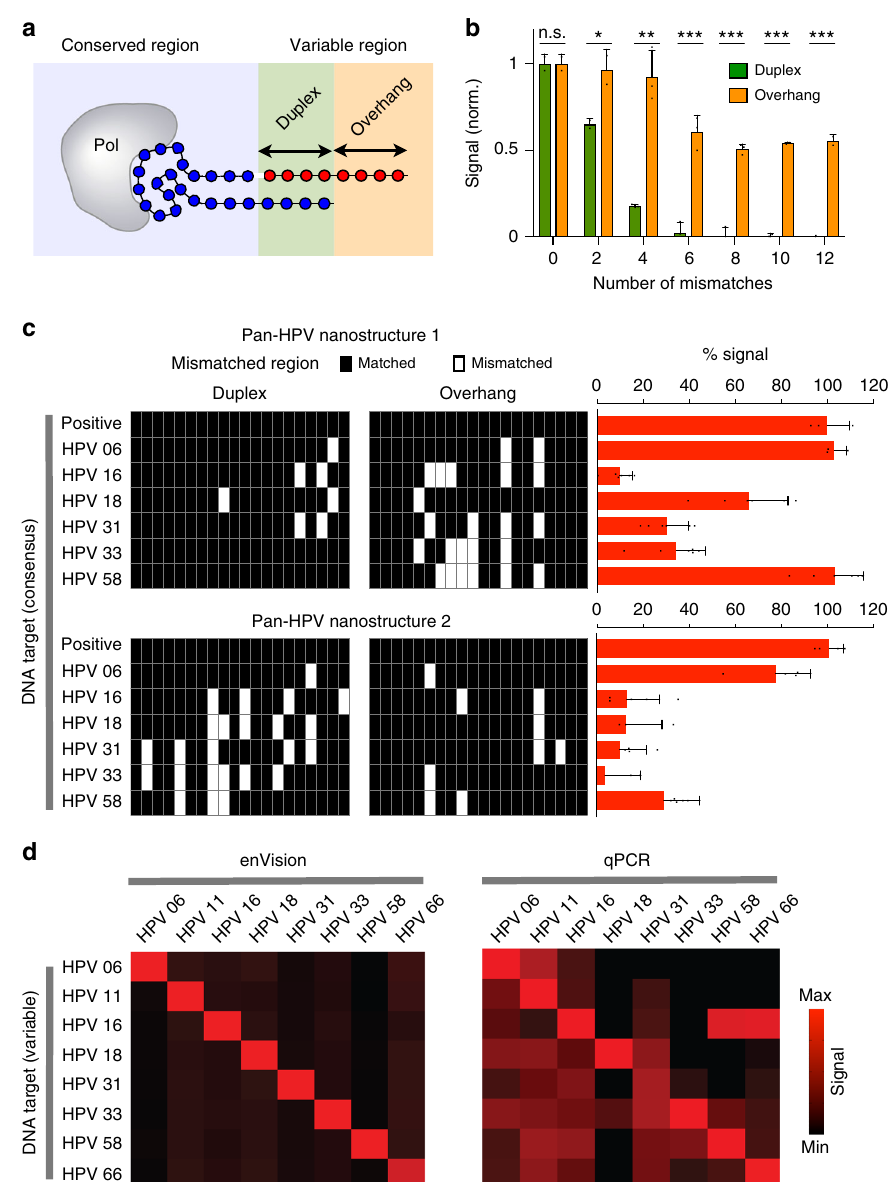
Fig. 3 Programmability of enVision. a Schematic of the programmable recognition nanostructure. The hybrid structure consists of a conserved sequence region, that binds to inactivate DNA polymerase (pol), and a variable region (duplex and overhang segments) that can be made complementary to target DNA. Not drawn to scale. b Effects of target mismatches in the variable region. Synthetic DNA targets, designed to have varying numbers of mismatches against the variable region, were incubated with the recognition nanostructure. All signals were normalized against that of the complementary DNA target (0 mismatch). Mismatches against the duplex region produced signi fi cantly lower signals (* P < 0.05, ** P < 0.005, *** P < 0.0005, n.s. not signi fi cant, Student ’ s t test). c Pan-HPV recognition. Two pan-HPV recognition nanostructures were developed according to the HPV consensus genome, to